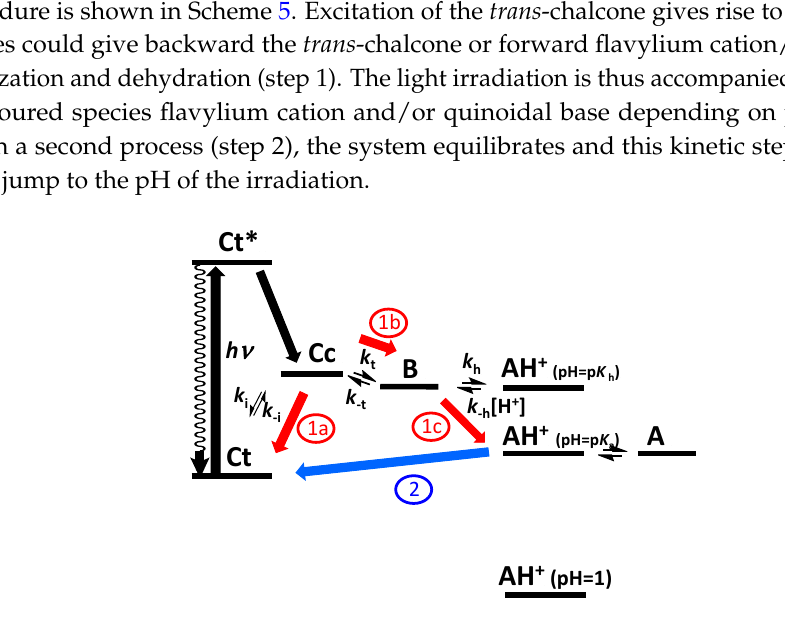
Scheme 5. Representation of the photochemical process in flavylium multistates.